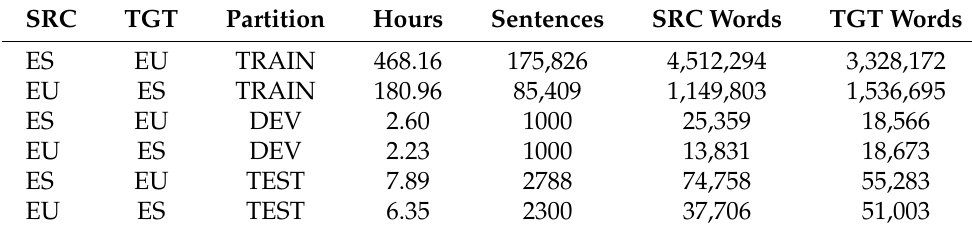
Table 5. mintzai-ST: final corpus statistics.